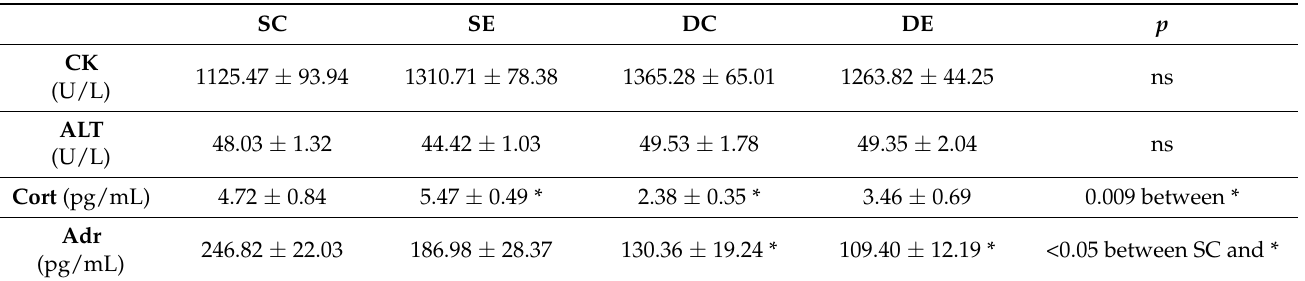
Table 1. The effects of Dex treatment, swimming, and a combination of these factors on liver and muscle damage markers and stress response elements.